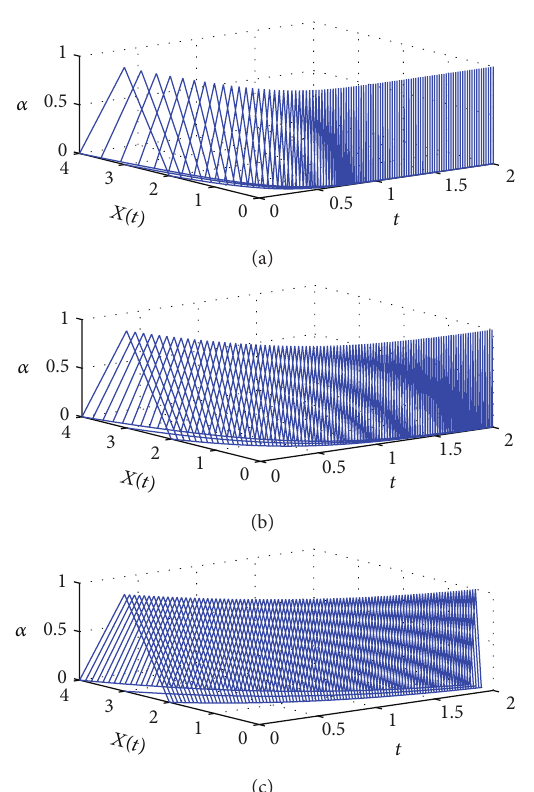
Figure 2: The numerical solutions of (46) for (a) 𝛽 = 0.6 , (b) 𝛽 = 0.8 , and (c) 𝛽 = 1